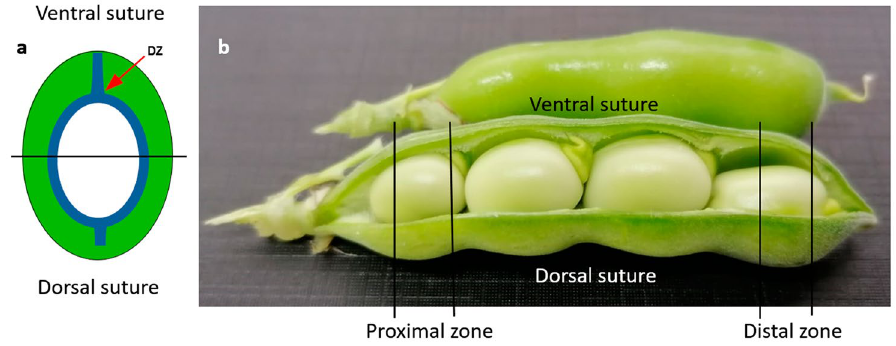
Figure 5. ( a ) Schematic representation of a pod transverse section. The blue line indicates lignin deposition. DZ, dehiscence zone. ( b ) Zones in pods where histological cuts were